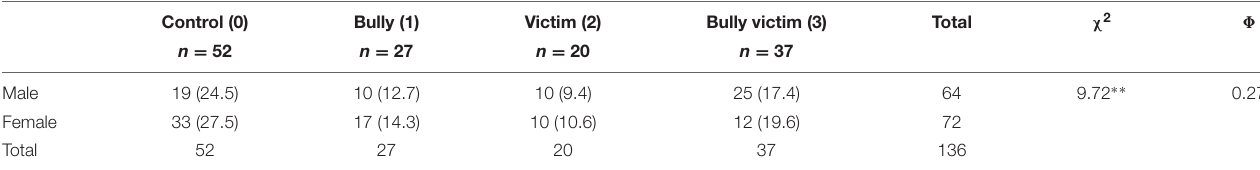
TABLE 2 | Cross-tabulation of sex according to bully